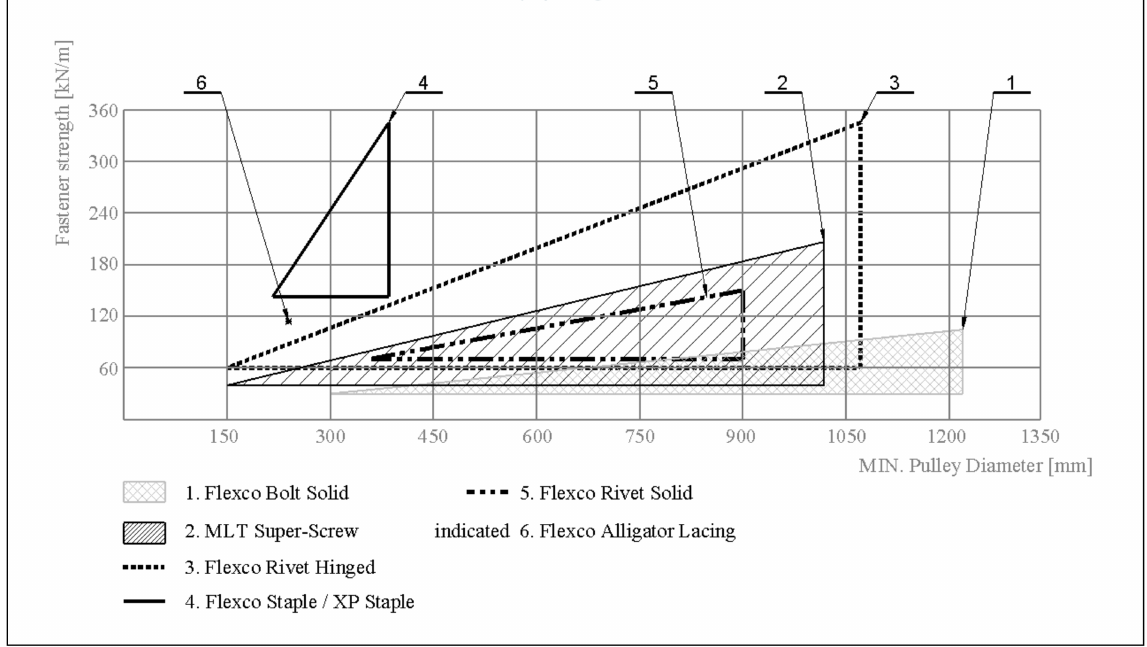
Figure 29. Design map for the selection of a mechanical connection in the range of MIN. Pulley diameter from 0 to approximately 1350 mm and in the range of fastener strength from 0 to approximately 360